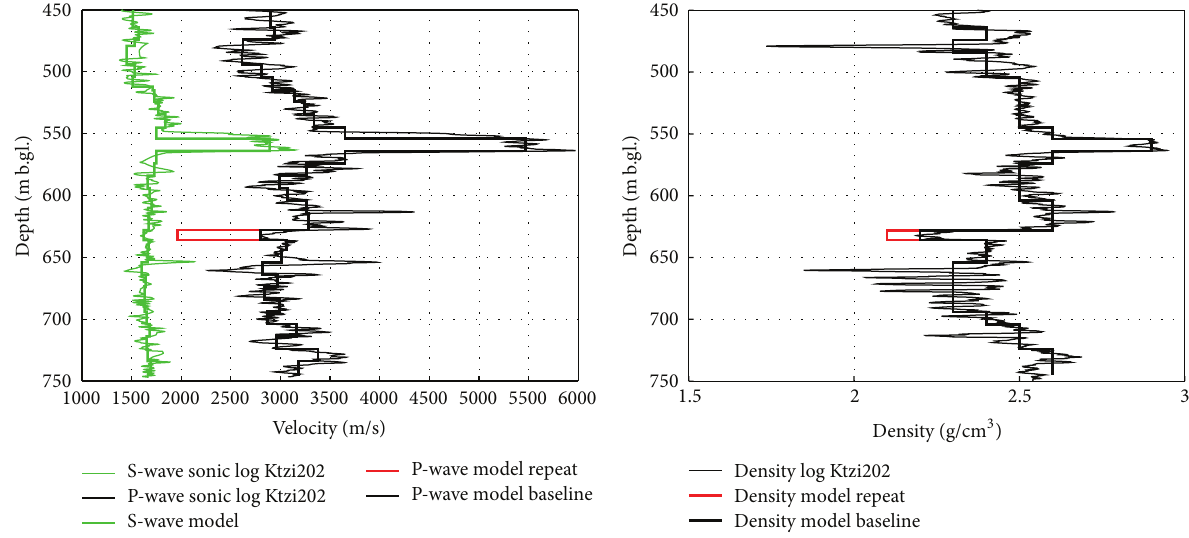
Figure 6: 1D seismic-elastic model based on sonic and density logs of the Ktzi202 observation well [21]. Left: P-wave and S-wave velocity model. Thin black line: P-wave sonic log of Ktzi202. Thick black line: blocky P-wave model layers. Red line: reservoir layer with a velocity reduction of 30%. Thin green line: S-wave sonic log of Ktzi202. Thick green line: blocky S-wave model layers. Right: density model. Thin black line: density log of Ktzi202. Thick black line: blocky density model layers. Red line: reservoir layer with a density reduction from 2.2 g/cm 3 to 2.1 g/cm 3 . The depth is in meter below ground level (m